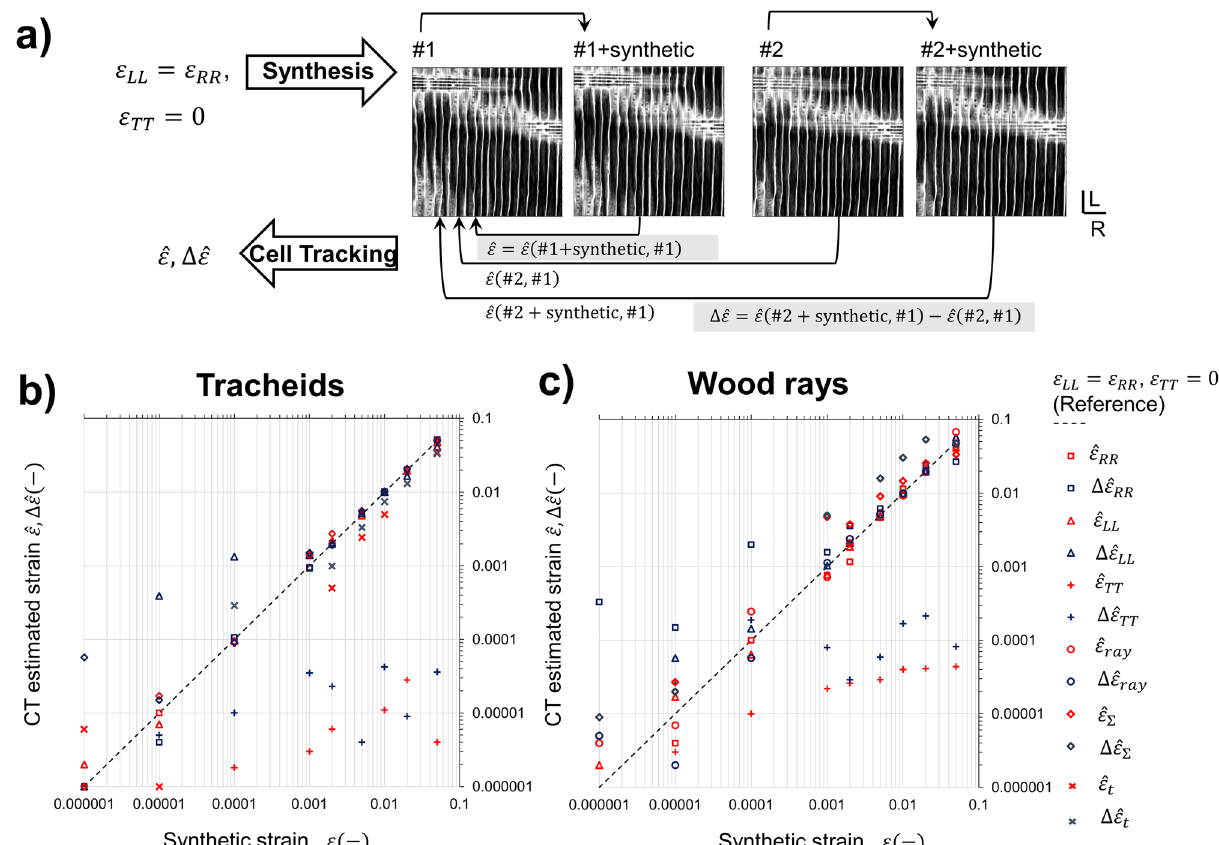
Figure 3. Validation of Individual Cell Tracking (ICT) method by estimation of synthetic deformation fields, which are introduced in experimental softwood SRμCT. ( a ) Data processing workflow for estimation of absolute ˆ ε and differential � ˆ ε accuracy of ICT strain measurements. For absolute accuracy, the same experimental dataset #1 is used as reference and to introduce synthetic deformation. For differential accuracy, deformation is introduced in a second experimental dataset #2, and estimated with respect to #1. Strain estimation results are shown for tracheids ( b ) and wood rays ( c ) for macroscopic strains ε ii , cell lumen ε � and cell wall ε t